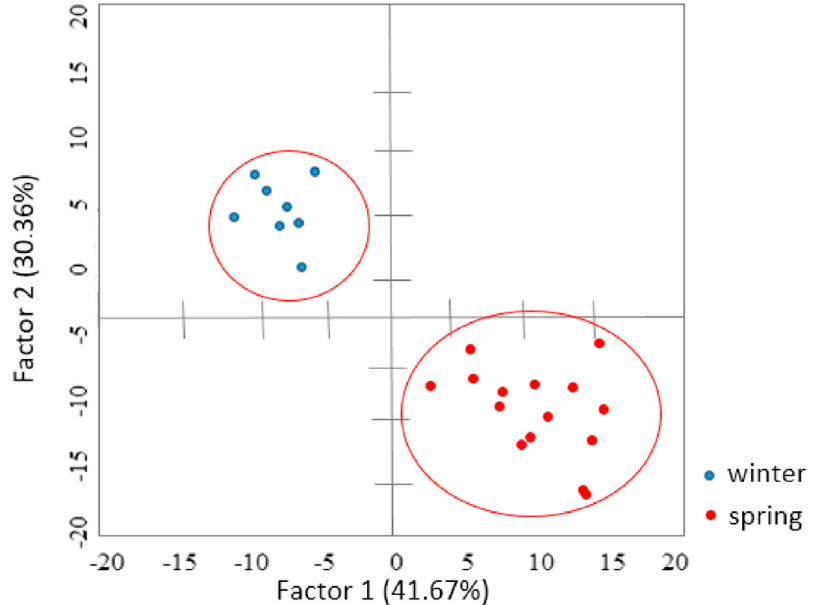
Figure 2. PCA analysis results, case projection on the plane for the entire population and all varia- bles. Lambda Wilk < 0.001, P < 0.001. Ellipses are 95% confidence intervals.